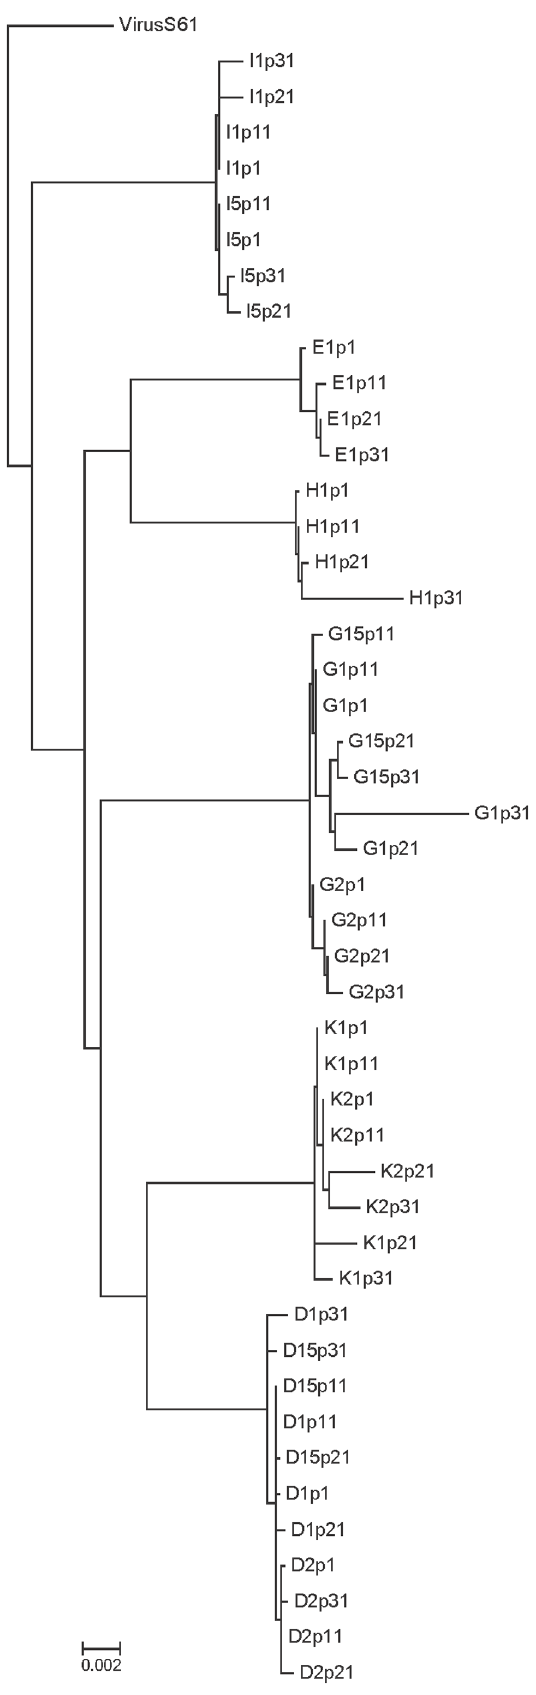
Figure 2. Maximum Likelihood phylogenetic tree of the studied viruses. Maximum Likelihood tree constructed with the complete genomic sequences of the studied viruses and the parental S61 virus. The tree parameters of the weighted evolutionary model were obtained previously by JModelTest and the tree was obtained by the PHYML program. Viruses grouped by lineages with some long branches. Bar represents the genetic